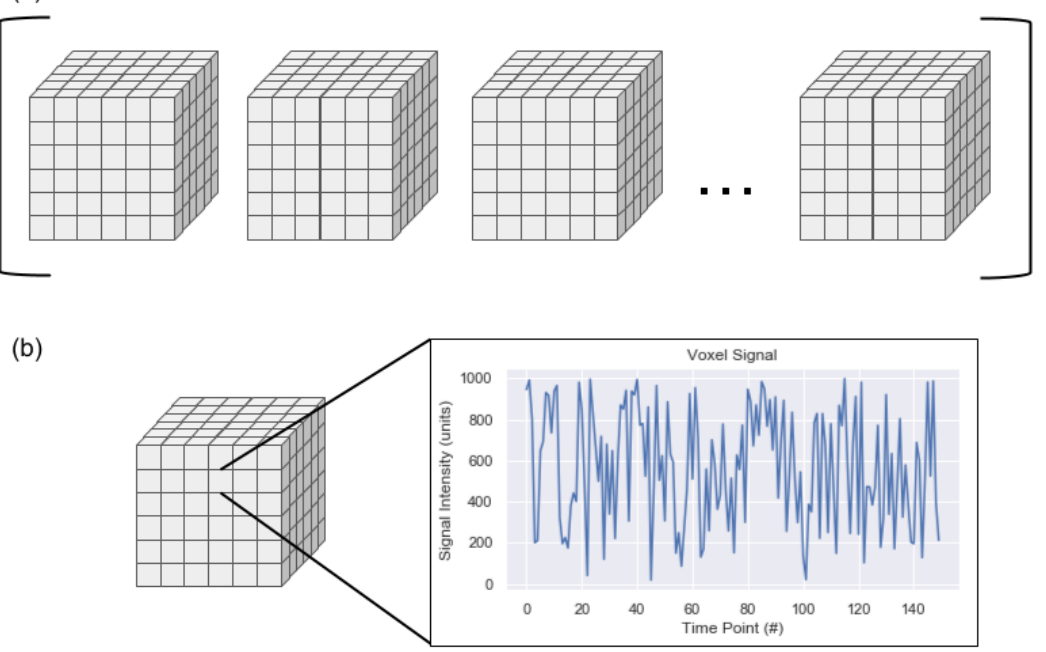
Figure 1. An rs-fMRI can be thought of as ( a ) an ordered list of three-dimensional image volumes where each voxel has a decimal value or as ( b ) a single three-dimensional image volume where each voxel contains a temporal signal.